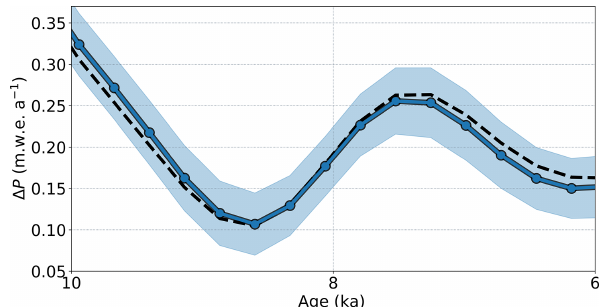
Figure 10. The blue line and shaded region show the estimated mean (cid:49)P and 95% confidence bands, respectively, for the sensi- tivity test, accounting for uncertainty in a number of ice flow and PDD model parameters. The dashed black line shows the mean es- timated (cid:49)P from a previous inversion assuming no uncertainty in model